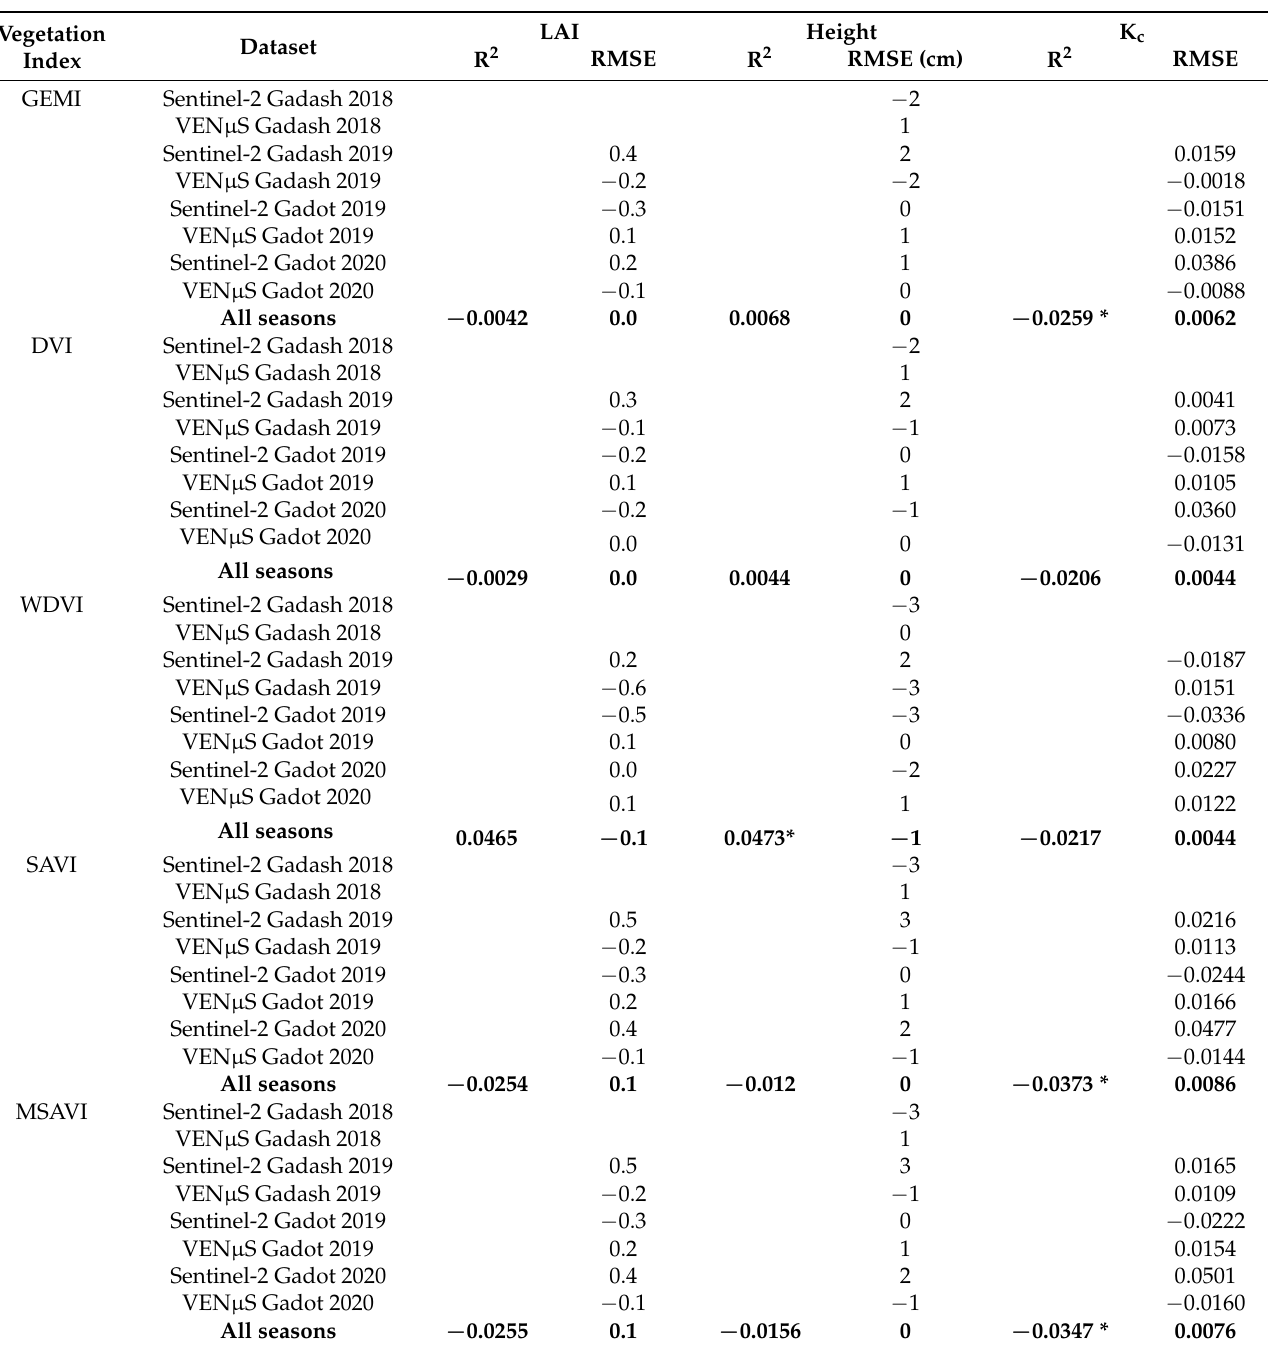
Table 8. Difference in performance statistics between newly developed S2/V T and S2/V NT -based LAI, Height, K c models for the best performing VIs. Positive R 2 and negative RMSE indicate the superior performance of the S2/V T model compared to the equal parameter of the S2/V NT model. Significant differences are marked with (*). Performance statistics of the difference of additional VIs can be found in Appendix